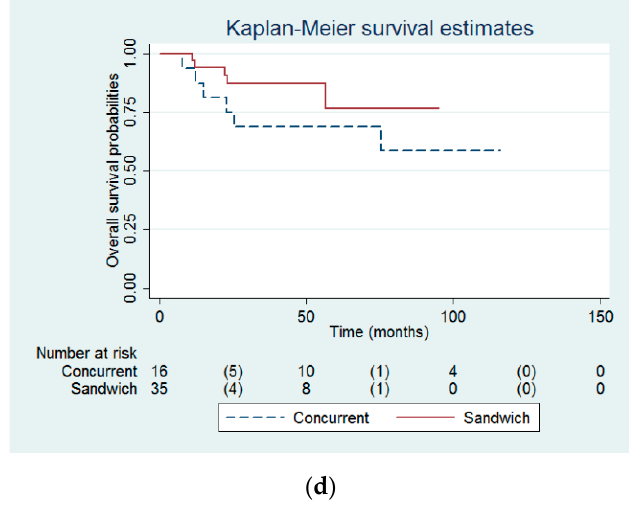
Figure 2. Probabilities of ( a ) progression-free survival and ( b ) overall survival of whole study population. Probabilities of ( c ) progression-free survival and ( d ) overall survival between the sandwich and concurrent chemoradiotherapy groups.